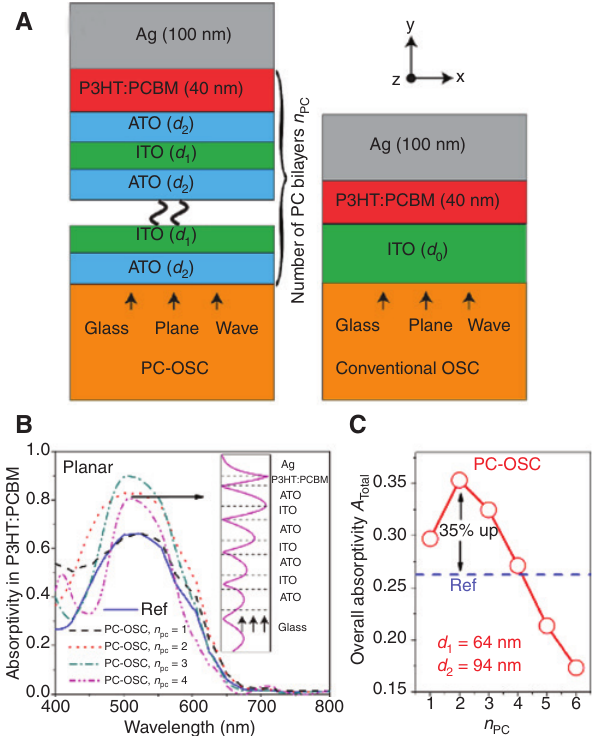
Figure 11: Optical Tamm states improve light absorption in OPVs. (A) Device structure of OPVs with designed PC (left) and conven- tional OPVs (right). (B) Theoretically simulated absorption spectra in the active layer under normal TM-polarized incidence with differ- ent numbers of PC bilayers ( n ). The active layer was P3HT:PCBM, pc = 64 nm (the thick- and the lattice parameters were chosen as d 1 = 94 nm (the thickness of ATO). (C) Simulated ness of ITO) and d 2 overall absorptivity A as a function of n (reprint with permission Total pc Ref. [172]; Copyright 2012 American Institute of